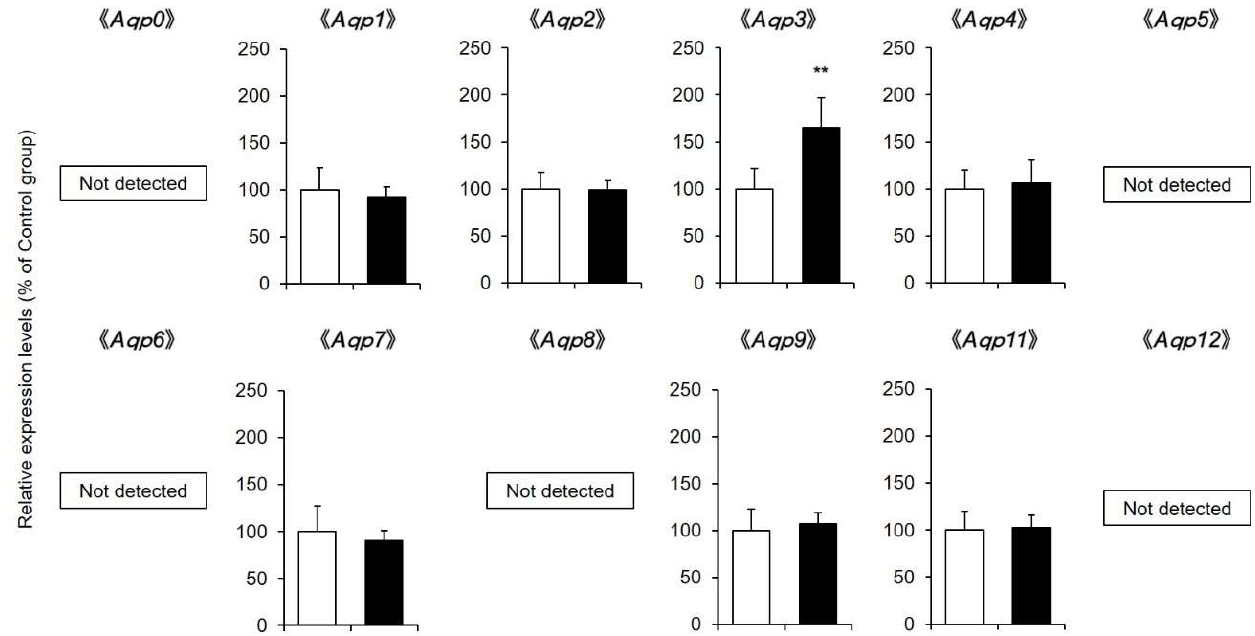
Figure 4. Aqp mRNA expression levels in the skin. A 1% CBD solution was applied to the back skin of mice for 14 days (black). A solvent was applied to the control group (white). After the treatment, the mRNA expression levels of Aqp in the skin were analyzed by real-time RT-PCR ( n = 6, means ± SD, ** p < 0.01 vs. the control group).